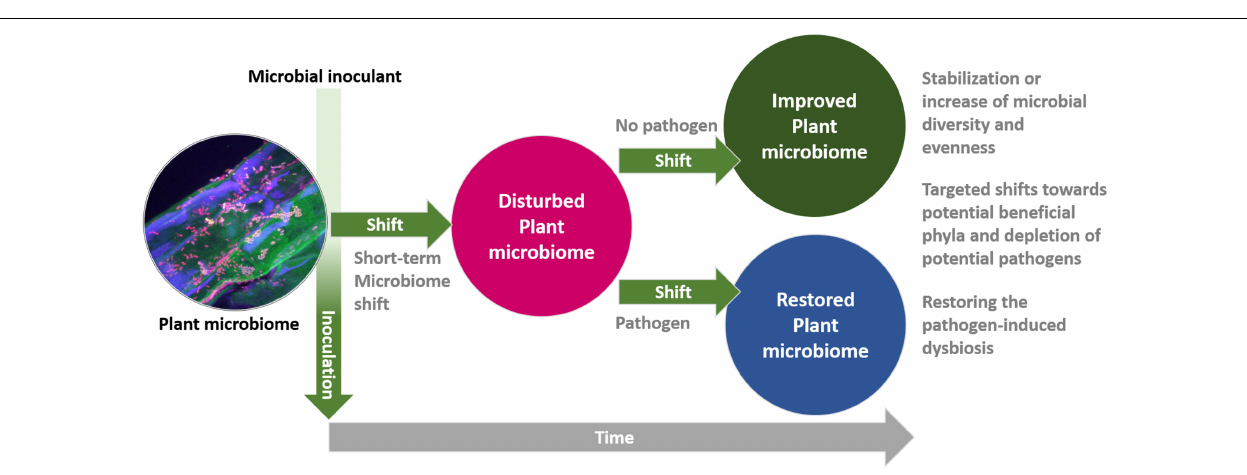
FIGURE 2 | A model for plant microbiome responses to microbial inoculants. Inoculation of microbial inoculants induces short-term shifts and improves or restores a healthy plant microbial community on a long